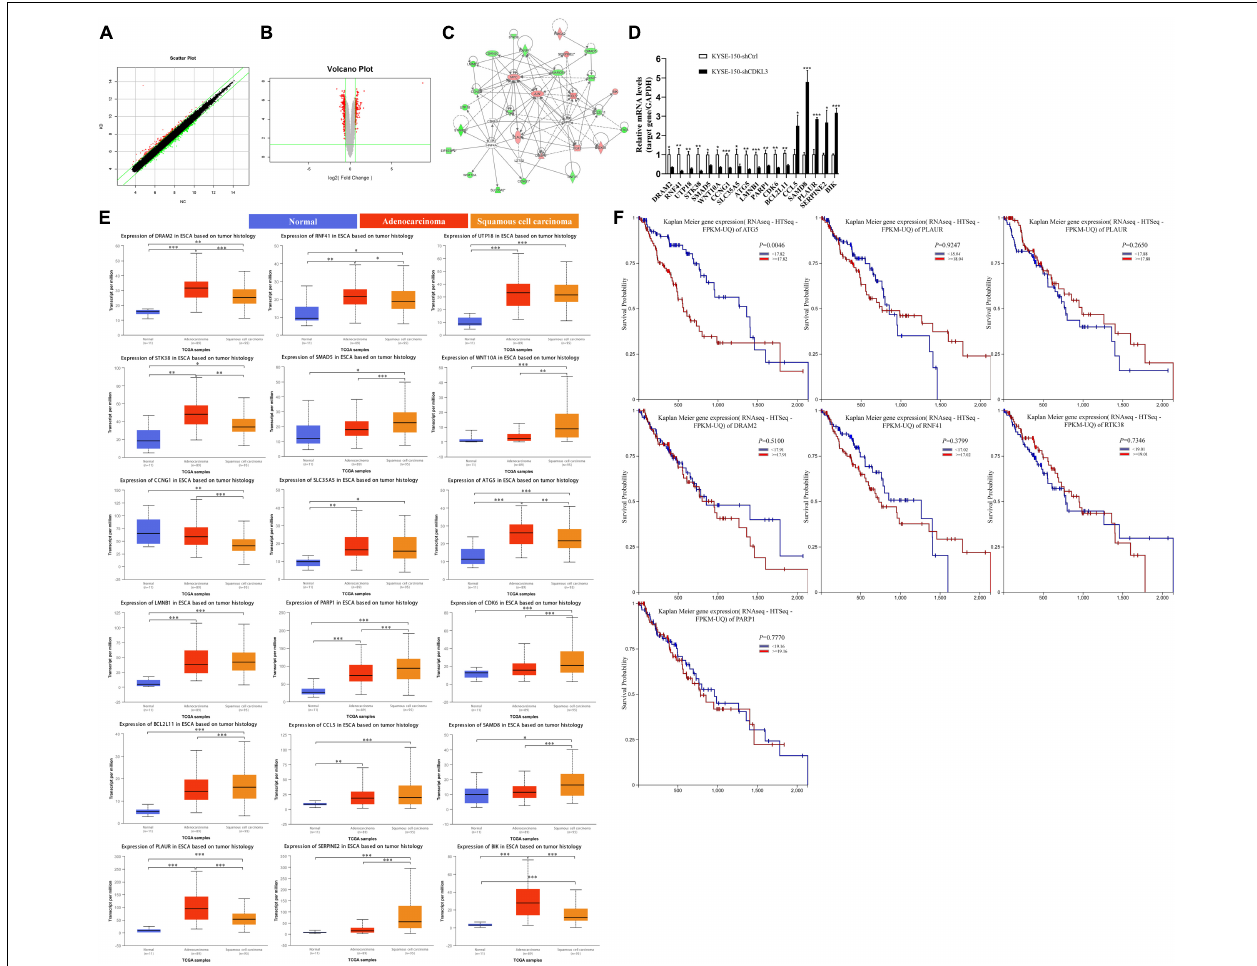
FIGURE 5 | ATG5 is a potential target of CDKL3. (A) A scatter plot demonstrated the distribution of the signal intensity between two groups in a Cartesian coordinate plane. The X -axis represents KYSE-150-shCtrl group, and the Y -axis represents the KYSE-150-shCDKL3 group. The dots above the upper parallel line represented the downregulated genes, while the dots under the lower parallel line represented the upregulated genes. (B) Volcano Plot exhibited the significantly differentially expressed genes between the two groups. The X -axis denotes the log2-fold difference and the Y -axis denotes the log10-corrected significant. The red dots represented the differentially expressed genes screened with the absolute value of Fold Change ≥ 1.5 and FDR < 0.05. (C) The interaction network illustrated the interrelationships among these 22 selected genes surrounding the regulation of CDKL3. The up-regulation gene was red while the down-regulation gene was green. The solid line represented the direct interactions while the broken lines represented the indirect interactions, and an arrow represented the activation. (D) RT-PCR was used to confirm the up-regulated and down-regulated genes induced by CDKL3 knockdown in KYSE-150 cells. (E) The expression patterns of the potential interacting genes in the TCGA database according to tumor histology. (F) Comparison of overall survival of esophageal cancer patients with different genes expression based on TCGA data. Data were represented as mean ± SD. * P < 0.05, ** P < 0.01, *** P < 0.001 vs. controls,